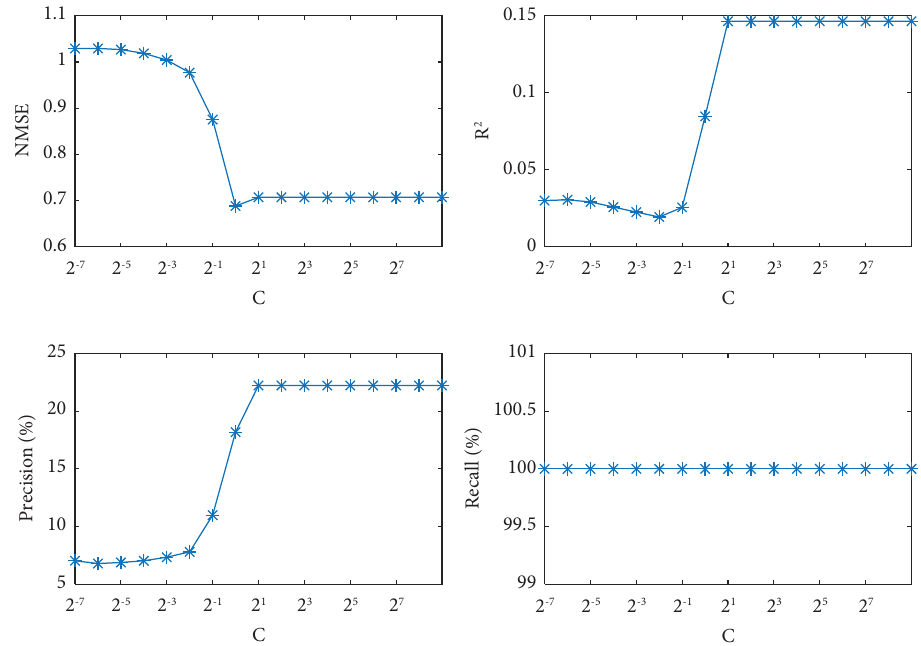
Figure 4: Te infuence of C on NMSE, R 2 , precision, and recall for the Type A dataset. Parameter p is fxed as the optimal